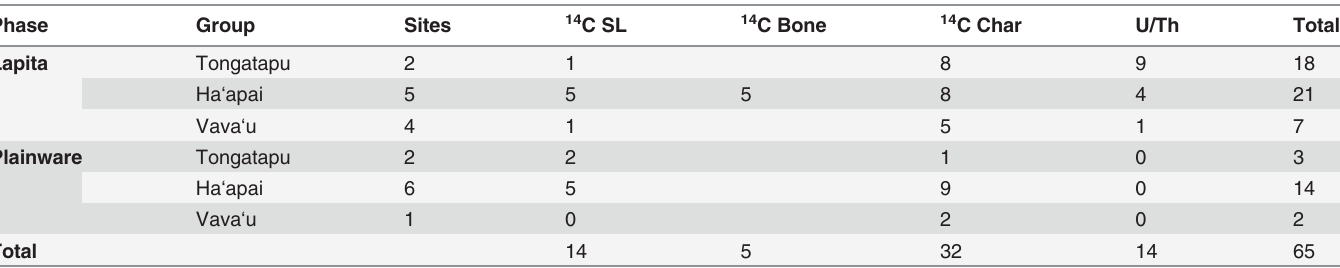
Table 1. Distribution of radiocarbon and U/Th dates by temporal phase and island